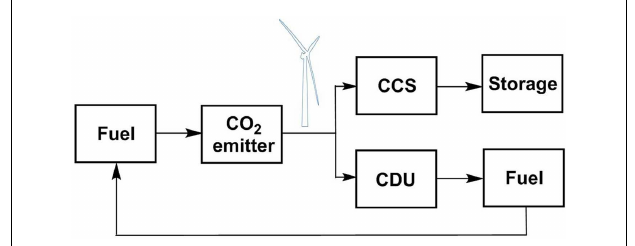
FIGURE 4 | Schematic representation a CDU recycling process in a combined CCS-CDU capture system, using wind energy to power the process